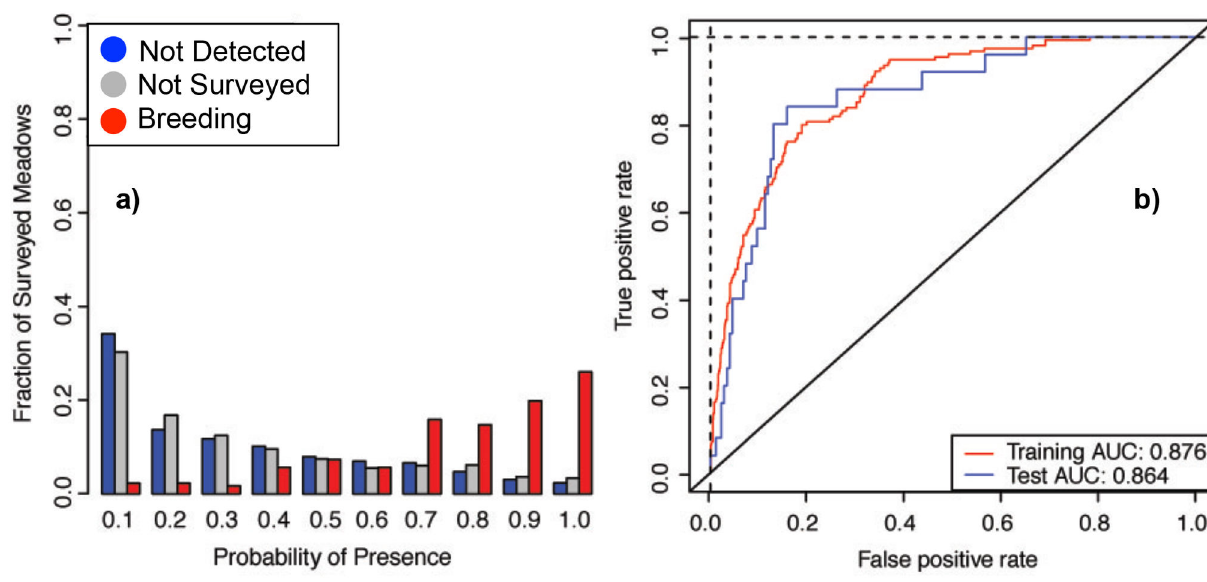
Figure 1. Performance of the “Environmental Model.”. a) The distribution of probabilities for the three classes of data for the Environmental Model (see Methods: “100subsampleGLM”). Data are combined from all surveys from 1996–2010. b) ROC plot for the training and test data. The red line shows the fit of the model to the training data, while the blue shows the fit relative to the test data. The curves represent those drawn from the average probabilities across 100